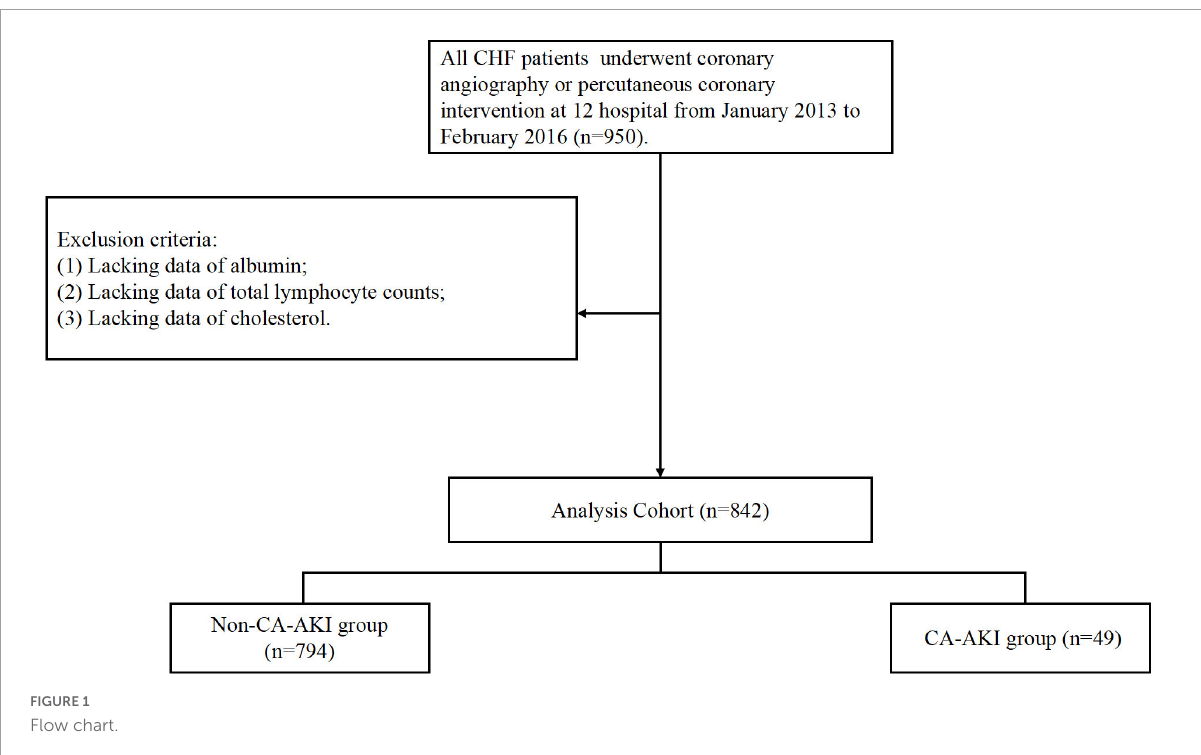
FIGURE1 Flow chart.